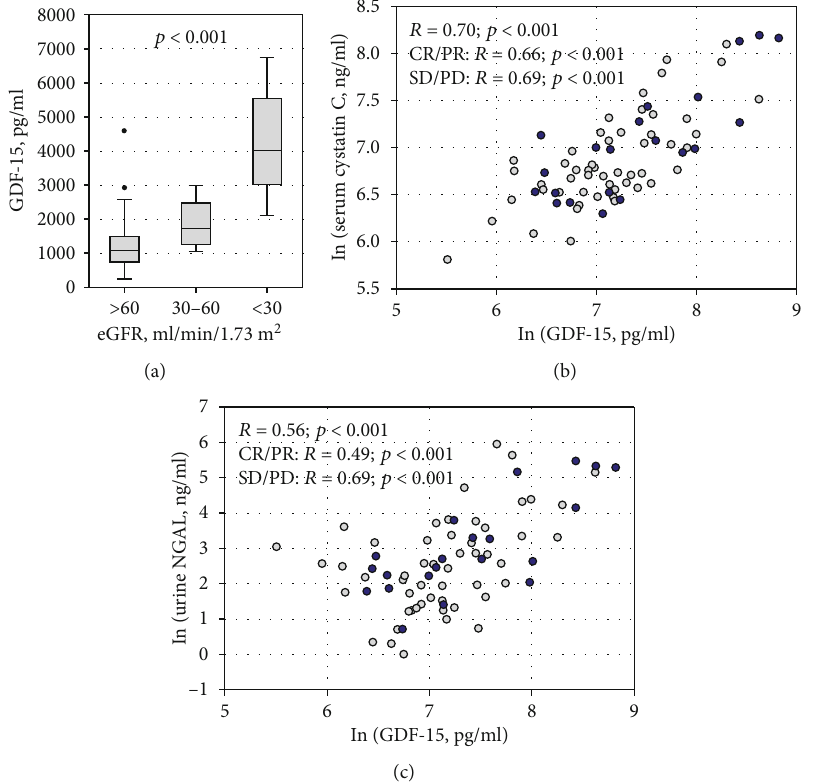
Figure 4: Serum GDF-15 concentrations among studied patients according to eGFR values: > 60ml/min/1.73 m 2 ( n = 47 ), 30- 60ml/min/1.73 m 2 ( n = 17 ), and < 30 ml/min/1.73m 2 ( n = 9 ) (a). Data are shown as median (horizontal line), interquartile range (box), nonoutlier range (whiskers), and outliers (points). Correlations between serum GDF-15 and cystatin C (b) and urine NGAL (c). Light circles represent patients with remission, and dark circles represent patients without remission. The right-skewed variables were transformed using natural logarithm (ln) to enhance readability. Spearman rank-order correlation coe ffi cients ( R ) in the whole studied group and the subgroups are shown with associated p values. Table 5: Simple and multiple Cox proportional hazard regression models to predict the two-year overall survival of the studied patients with MM. Simple regression Multiple regression Independent variable Hazard ratio (95% con fi dence interval) p value Hazard ratio (95% con fi dence interval) p value ISS II or III 5.53 (1.76-17.39) On CTx treatment 13.02 (2.93-57.95) CTx: chemotherapy; GDF-15: growth di ff erentiation factor 15; ISS: International Staging System for multiple